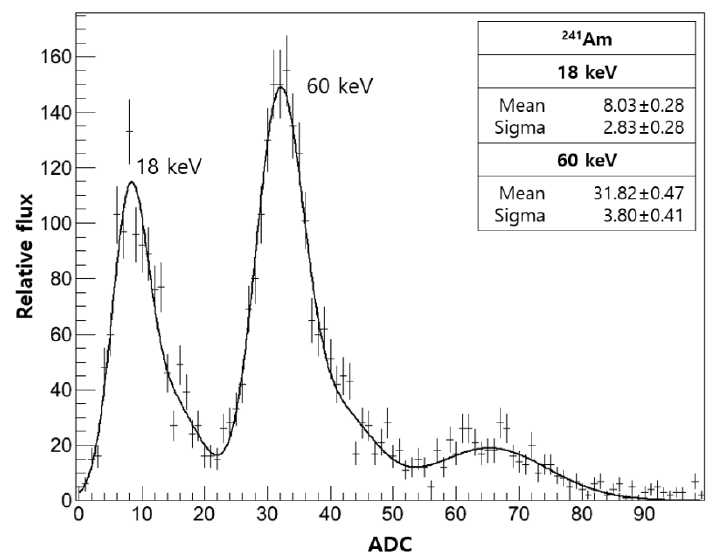
Figure 5. Energy measurements with 241 Am X-ray source. ADC counts versus relative flux. 241 Am has two peaks at 18 and 60 keV. The solid line represents a fit to the function of the linear sum of five Gaussians.